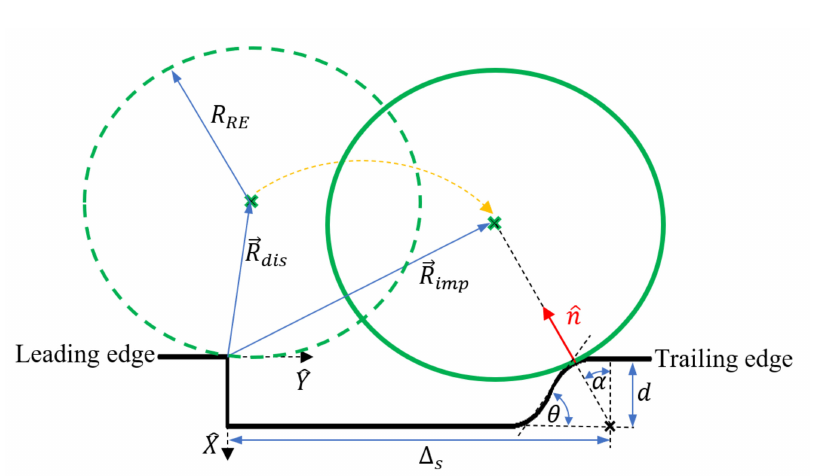
Figure 2. Geometric parameters definition at the moment of the RE disconnect from the raceways and impact on the trailing